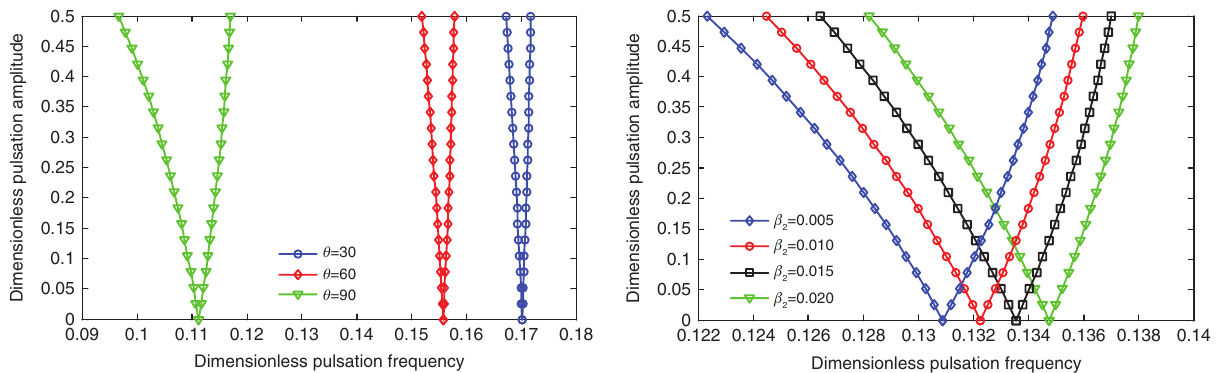
Figure 3: Effect of the BNNT orientation angle on the dimensionless pulsation amplitude versus dimensionless pulsation frequency.